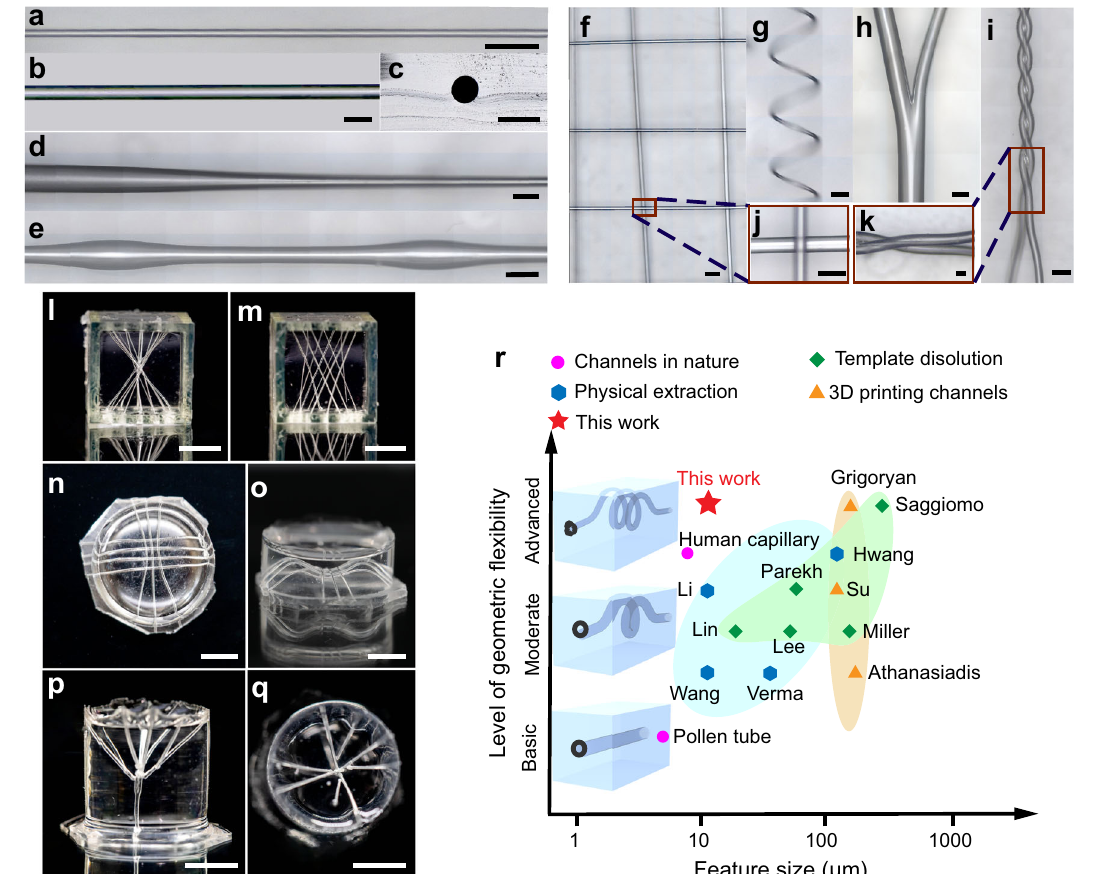
Fig. 4 | Microchannel structures fabricated by soft demoulding. a The thinnest channel (10 µ m in diameter) fabricated in this work. Scale bar, 50 µ m. b , c The microchannel and its circular cross-section. Scalebars, 50 µ m. d The microchannel with tapered geometry. The diameter of the left side of the tapered channel is 250 µ m, and the right-side diameter is 40 µ m. Scale bar, 200 µ m. e The micro- channel with a spindle-knotted shape. Scale bar, 500 µ m. f The microchannel lat- tice. Scale bar, 500 µ m. g The helical microchannel. Scale bar, 200 µ m. h The